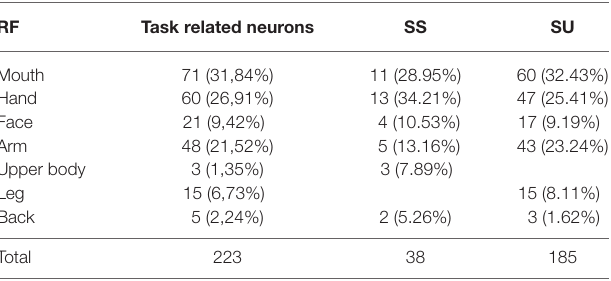
TABLE 1 | Localization of receptive fields of task related neurons, SS and SU